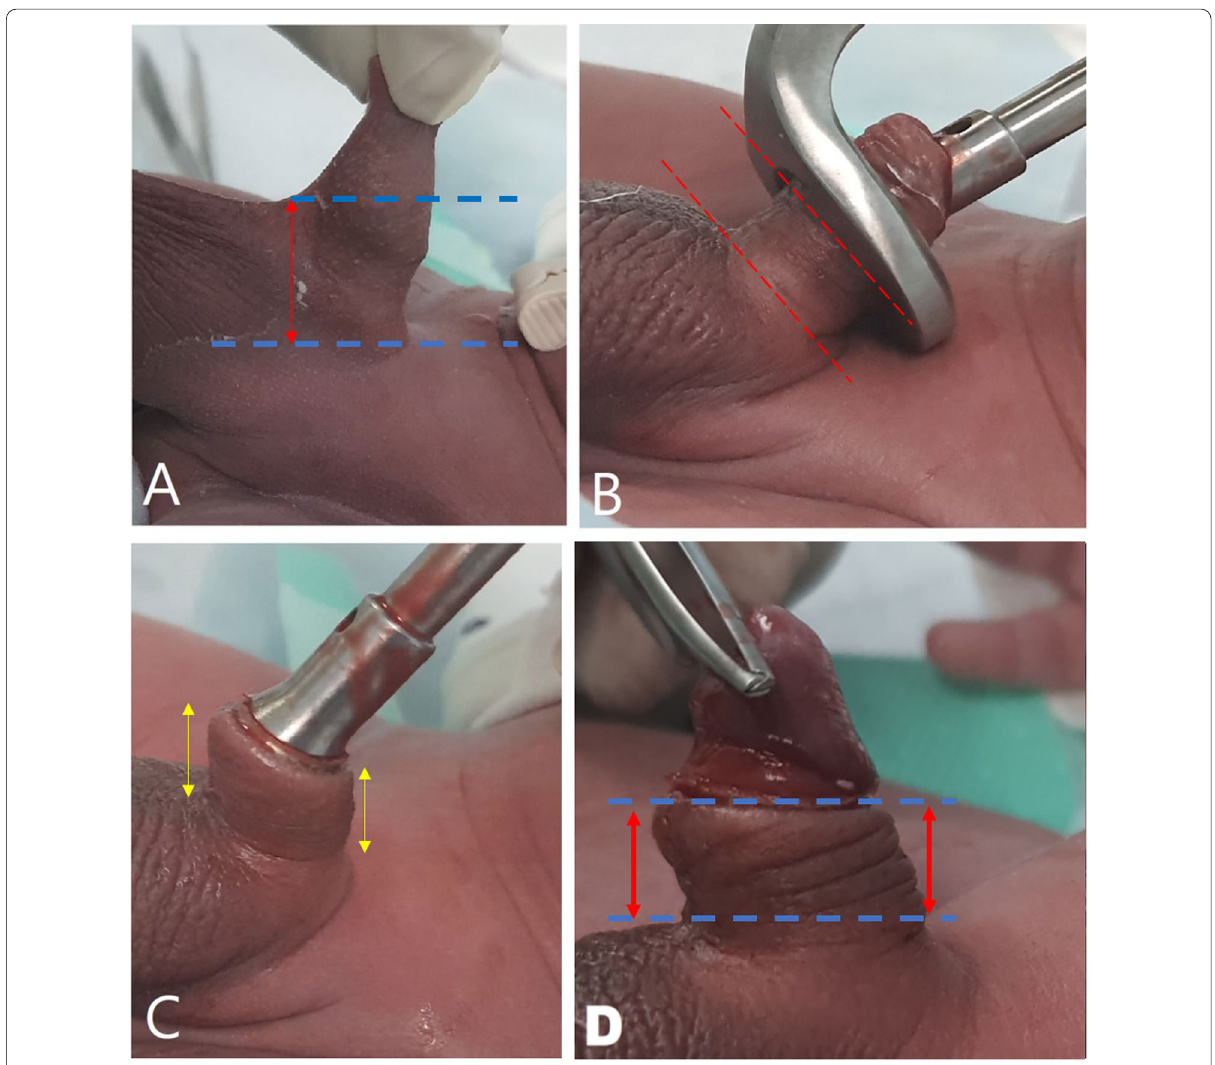
Fig. 3 Circumcision technique: A the discrepancy between the dorsal and ventral skin, B Gomco clamp was applied obliquely to have equal cylindrical shaft skin, C hemostasis was achieved. D the final appearance at the end of the procedure with even skin on both